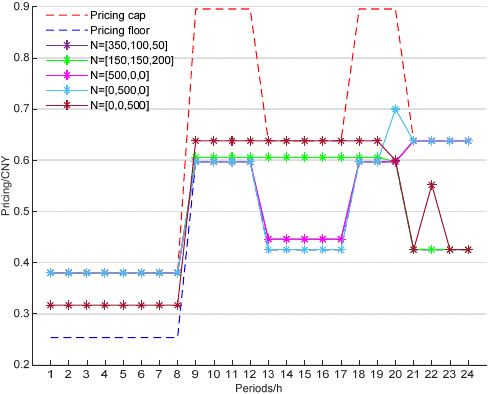
Figure 9. VPP pricing results under different EV proportions.